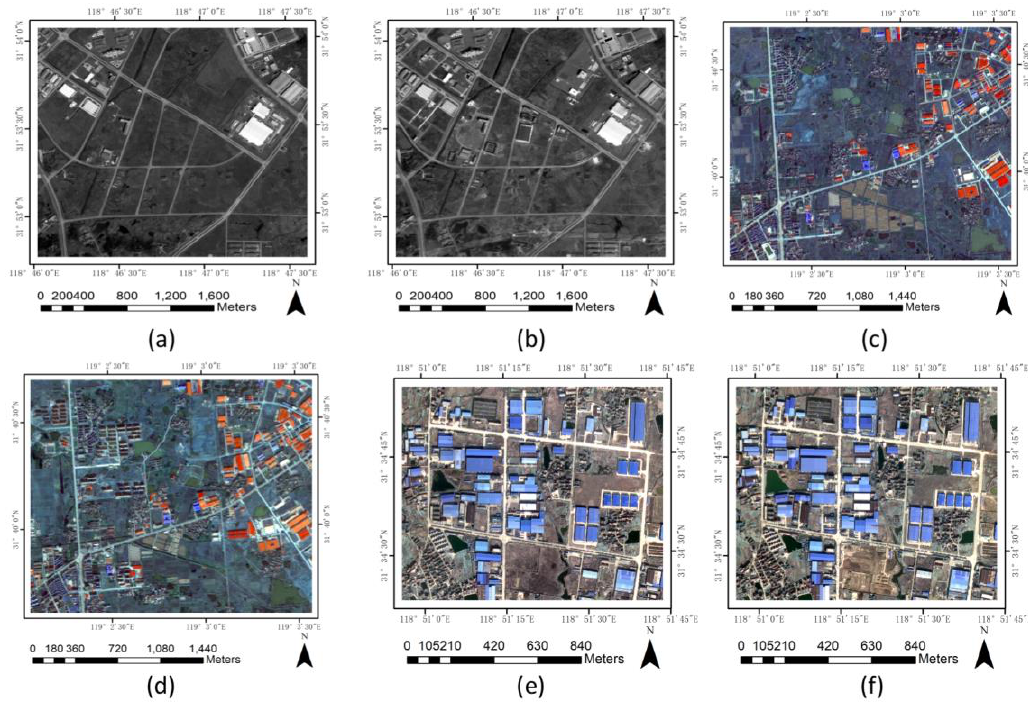
Figure 4. Three experimental areas. ( a , b ) Original bitemporal images of area 1. ( c , d ) Original bitemporal images of area 2. ( e , f ) Original bitemporal images of area 3.